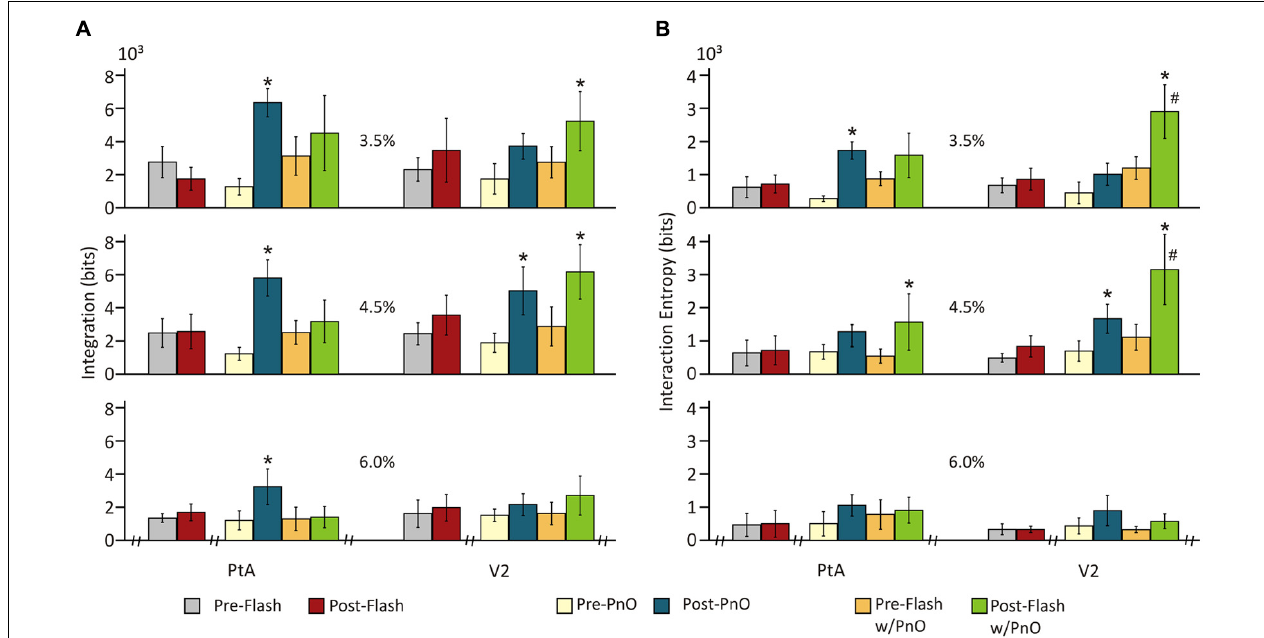
FIGURE 5 | Integration and interaction entropy before and after combined PnO and flash stimulation. Visual stimulation (light flashes) alone did not affect (A) integration or (B) interaction entropy. PnO stimulation led, as in Day 1, to an increase in integration and interaction entropy. Light